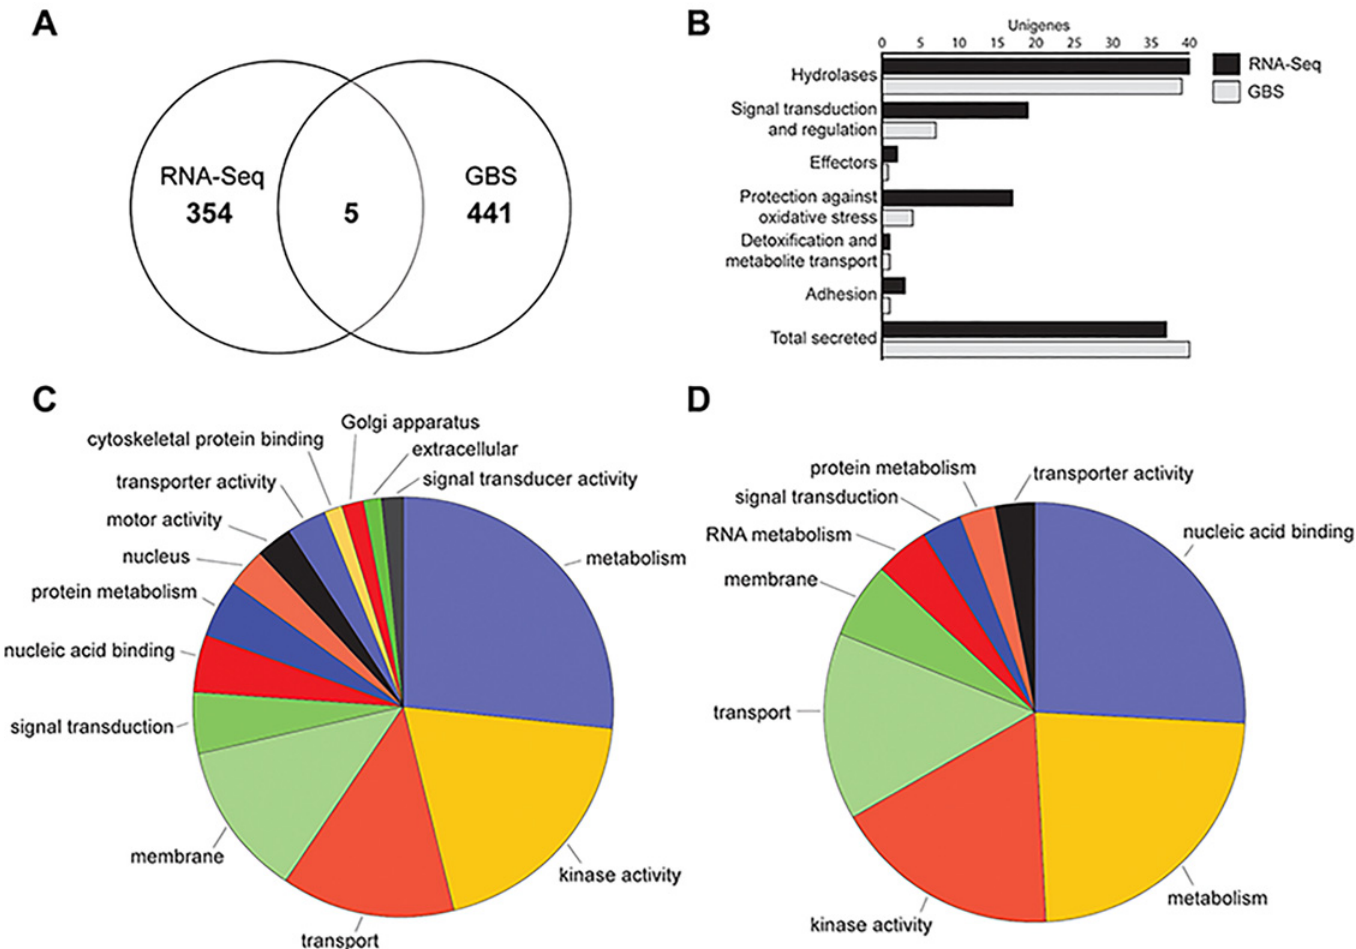
Fig 4. Characterization of unigenes containing PCA-correlated SNPs between Pseudoperonospora cubensis and P . humuli isolates sequenced using RNA-seq and GBS. Using the P . cubensis reference genome [24,25], unigenes were identified that contained PCA-correlated SNPs from GBS and RNA-Seq data. The number of unigenes identified in each technique, as well as the number of overlapping unigenes are shown in (A). (B) Unigenes classified as putative pathogenicity genes. Gene ontology (GO) of unigenes from (C) RNA-Seq (n = 179) and (D) GBS (n = 89) assigned in terms of the associated biological processes, cellular components and molecular functions.